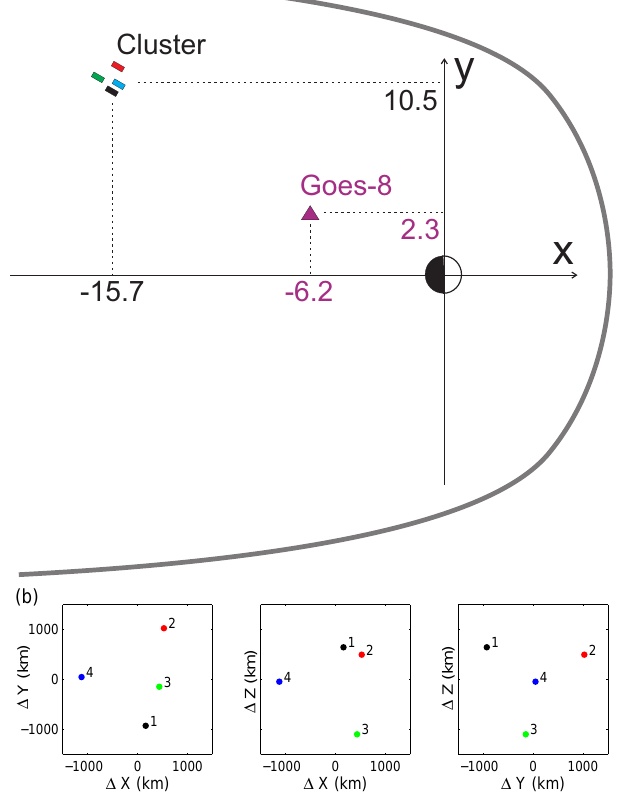
Fig. 1. (a) Cluster and Goes-8 satellites in the magnetosphere at 03:30 UT on 11 October 2001. In GSM coordinates their locations were: Cluster at [− 15 . 7 , 10 . 5 , 2 . 5 ] R E and Goes-8 at [− 6 . 2 , 2 . 3 , − 0 . 7 ] R E . The magnetopause drawn is a sketch only. Earth and the satellites are not to scale. (b) The relative locations of the four Cluster spacecraft. Cluster 1 is black, C2 red, C3 green and C4 blue. The figures are centered at the barycentre of the tetra-